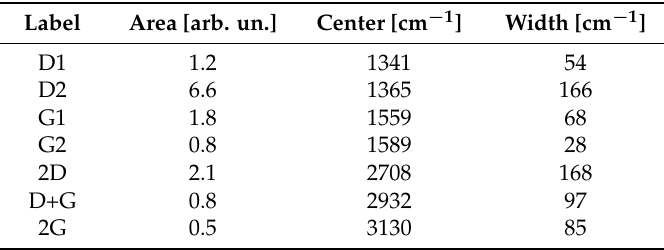
Figure 7. Raman spectrum of CGB. Table 1. Decomposition of peaks in Raman spectrum of CGB.